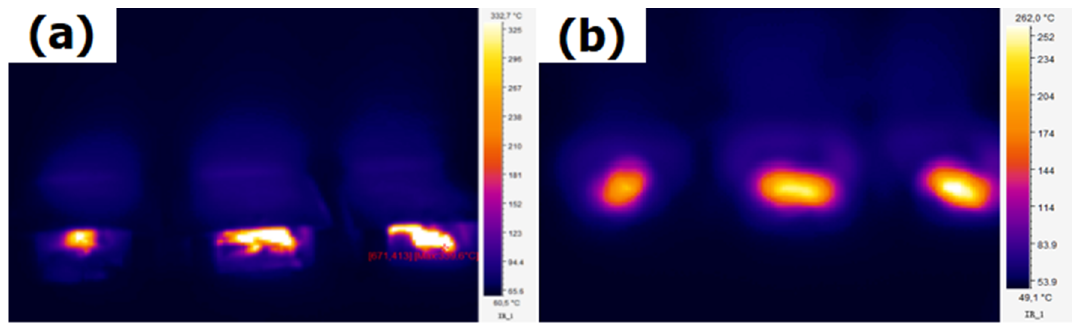
Figure 13. ( a ) Integrated image of the three fuels; ( b ) emissions in the form of radiant bodies for the three fuels.